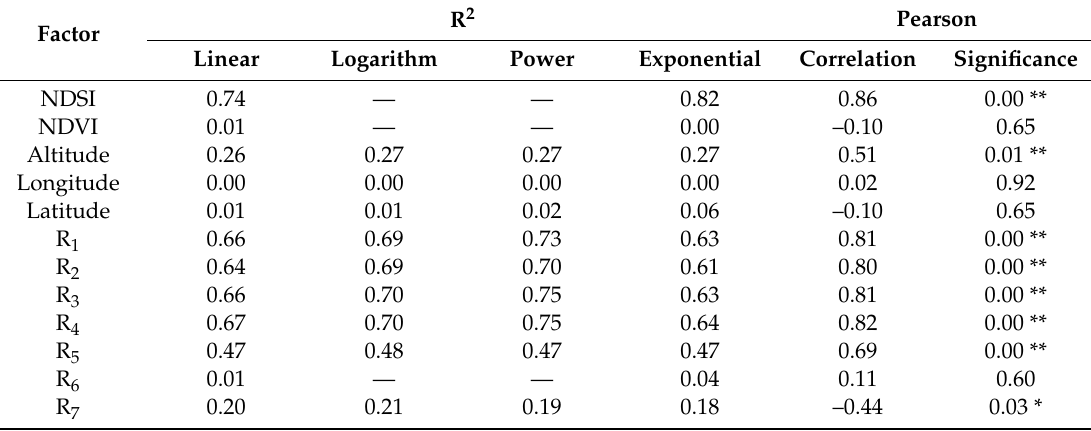
Table 2. Significance test between each influencing parameter and the FSC.